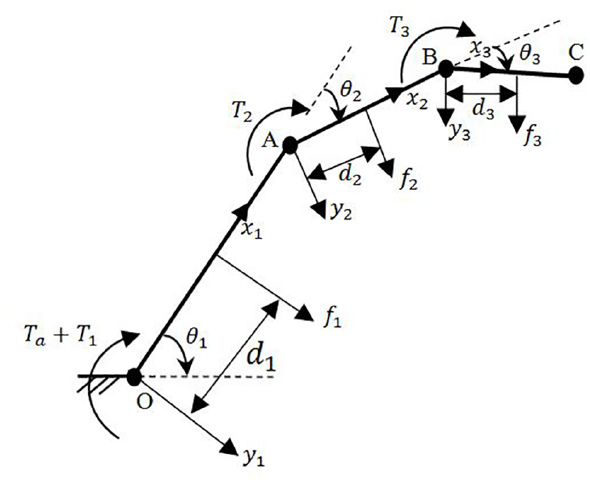
Figure 3. CPRF geometric model with input and output